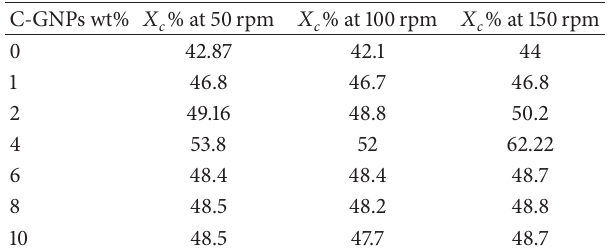
Table2:Crystallinitypercentageofpreparedcompositesatdifferent